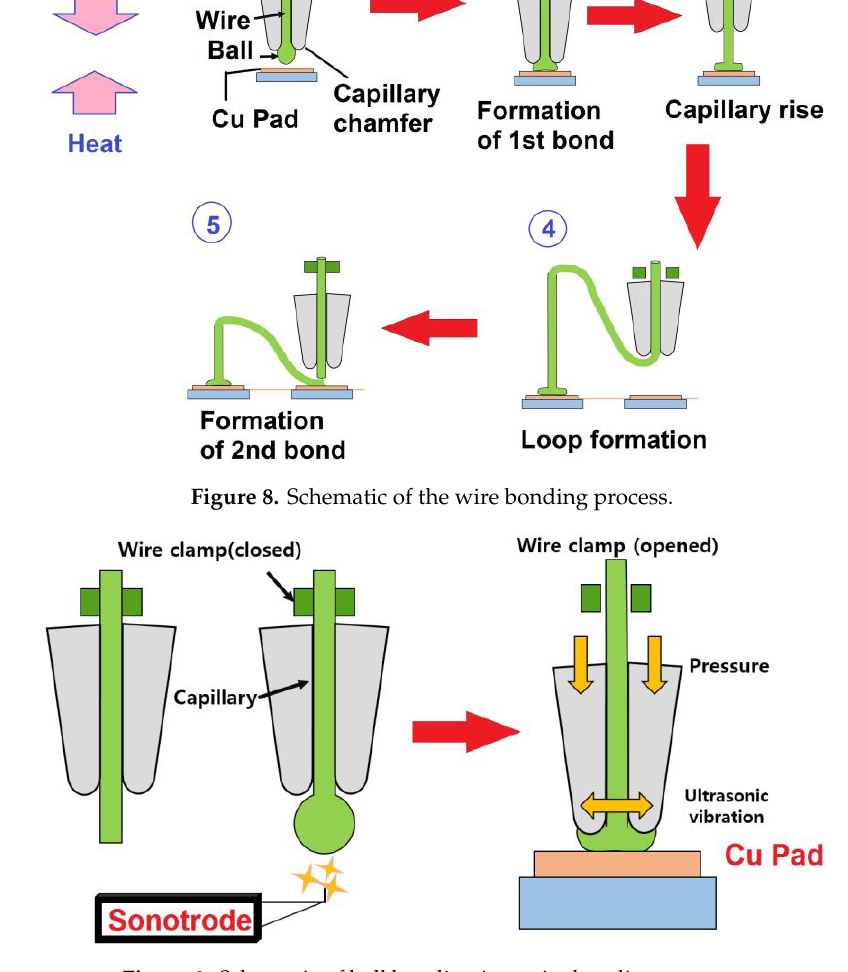
Figure 9. Schematic of ball bonding in a wire bonding process.